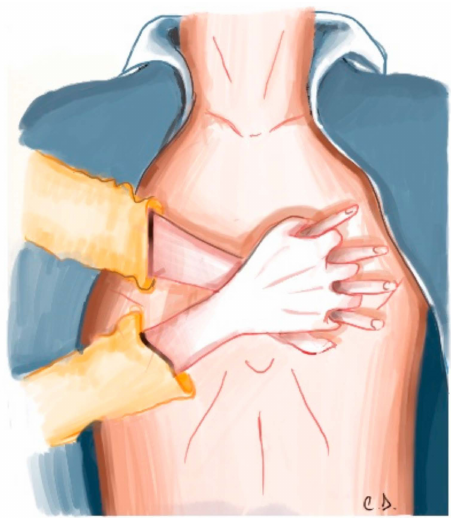
Figure 3. Location of chest